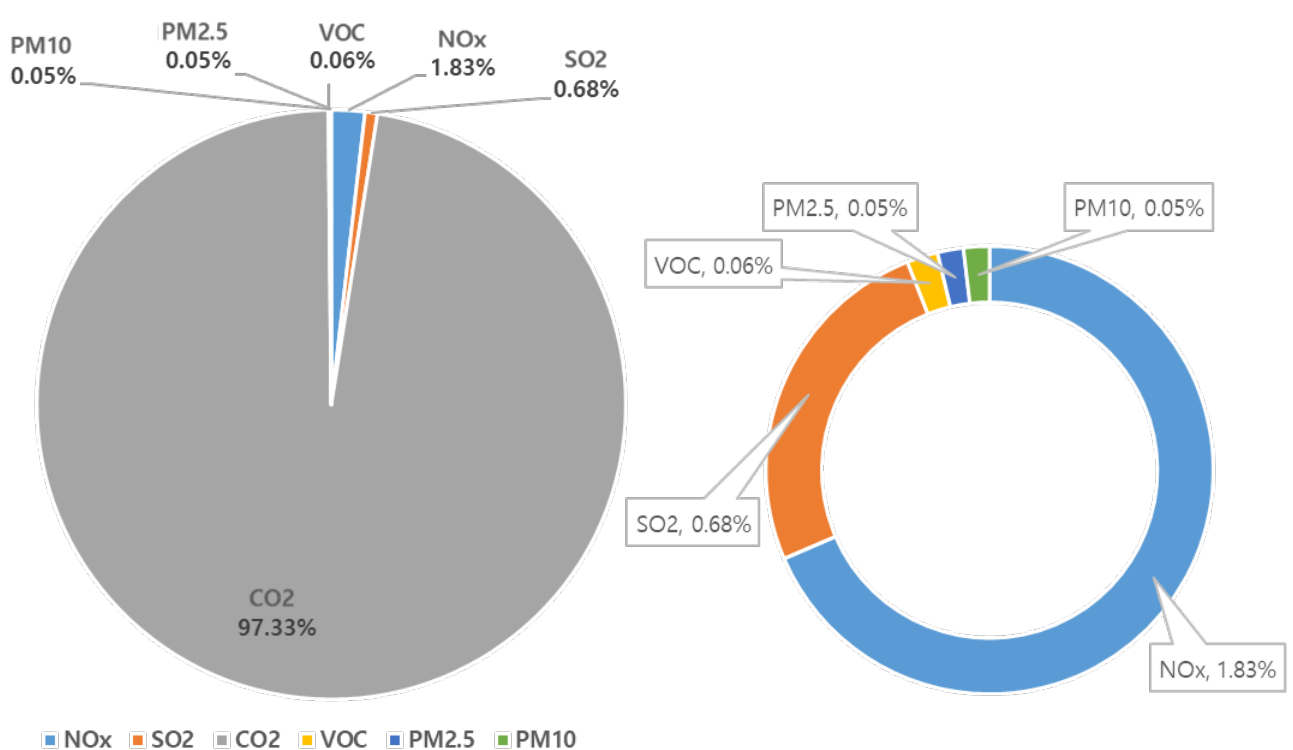
Figure 4. Ship emissions rate of the major pollutants at Busan Port from 2015 – 2019 during hoteling.